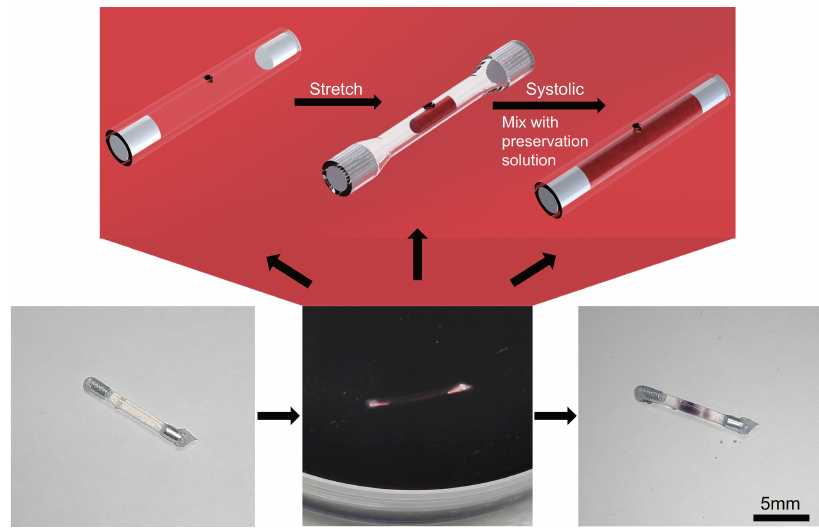
Figure 10. Illustration of material sampling by the millirobot. The MHCMM cavity was filled with water and then put into a colored solution for sampling testing.